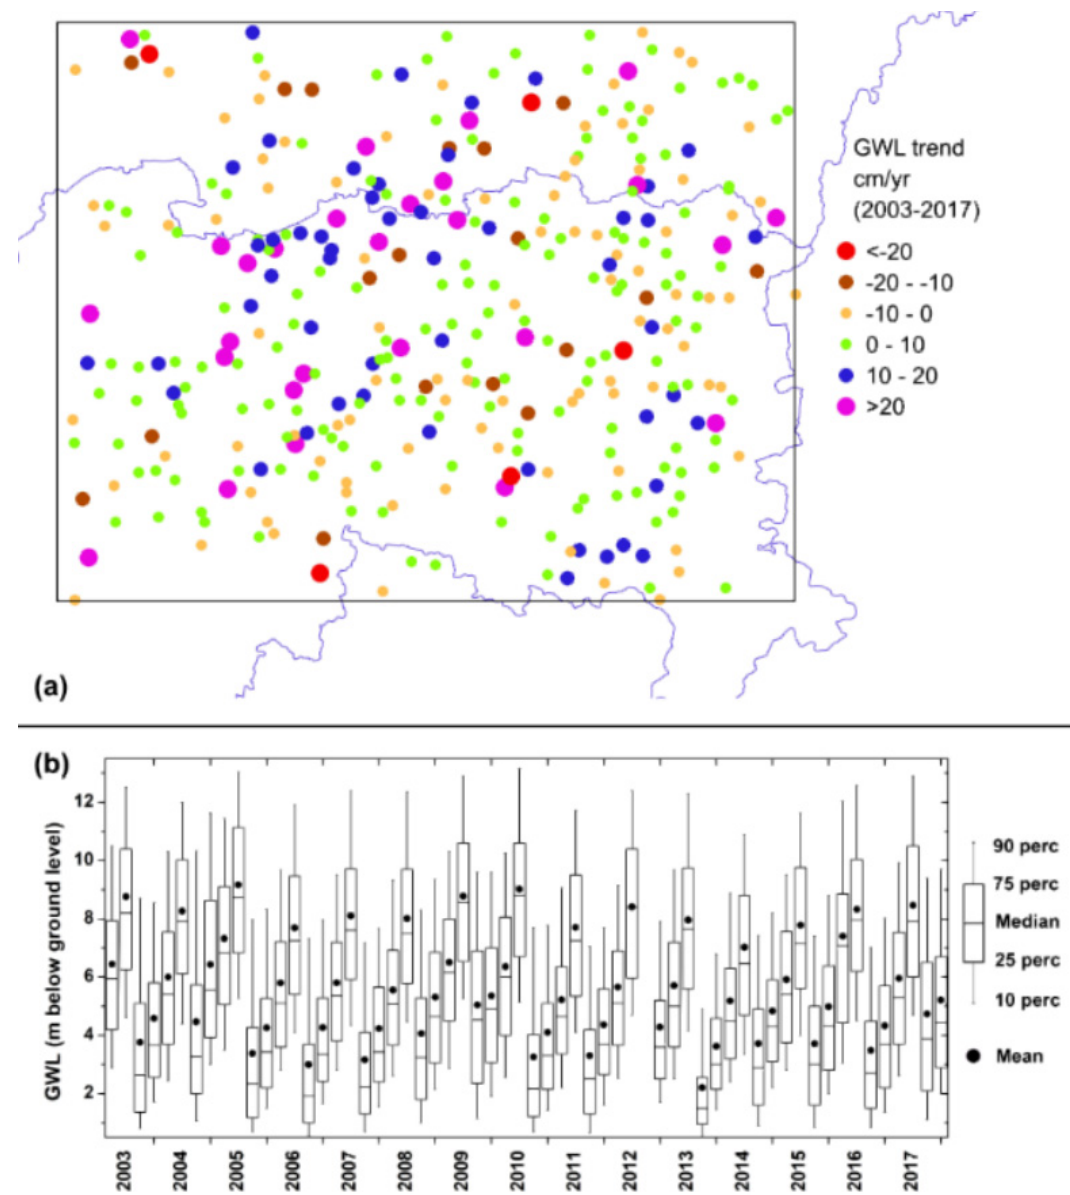
Figure 5. ( a ) Spatial trends in in situ groundwater level between 2003 and 2017; ( b ) box plot of in situ groundwater level (n = 347). Symbols representing the mean, median, maximum, 10th percentile, 25th percentile, 75th percentile and 90th percentile are shown in inset.